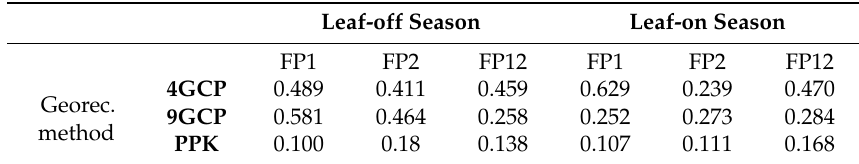
Table 4. Vertical root mean square errors (RMSE z ) of validation points used in Photoscan software (in meters).